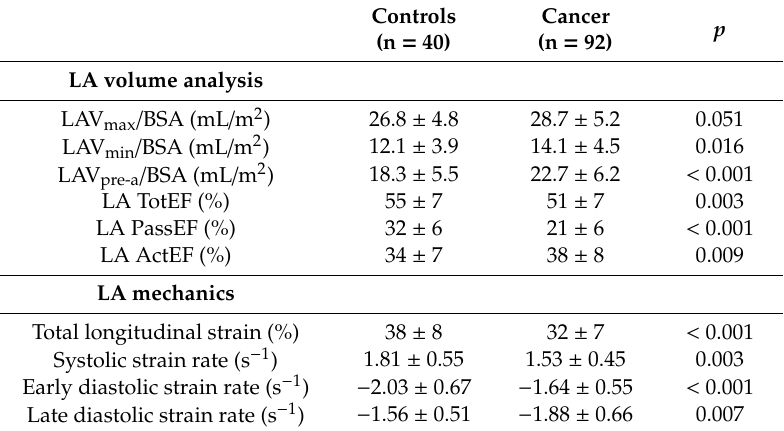
Table 3. LA phasic function determined by volumetric and strain method in the study population